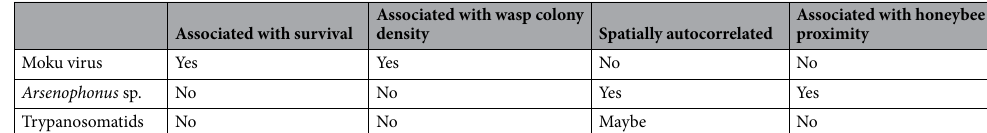
Associated with honeybee proximity